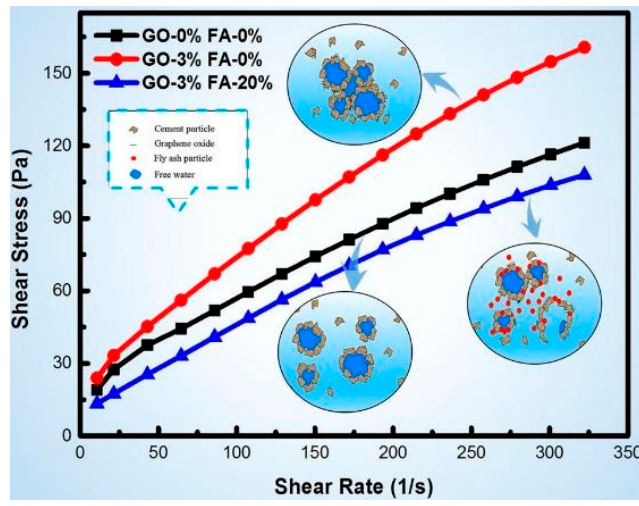
Figure 20. Impact of fly ash on flow curves of GO cement paste. Reproduced with permission from [127], Elsevier, 2017.